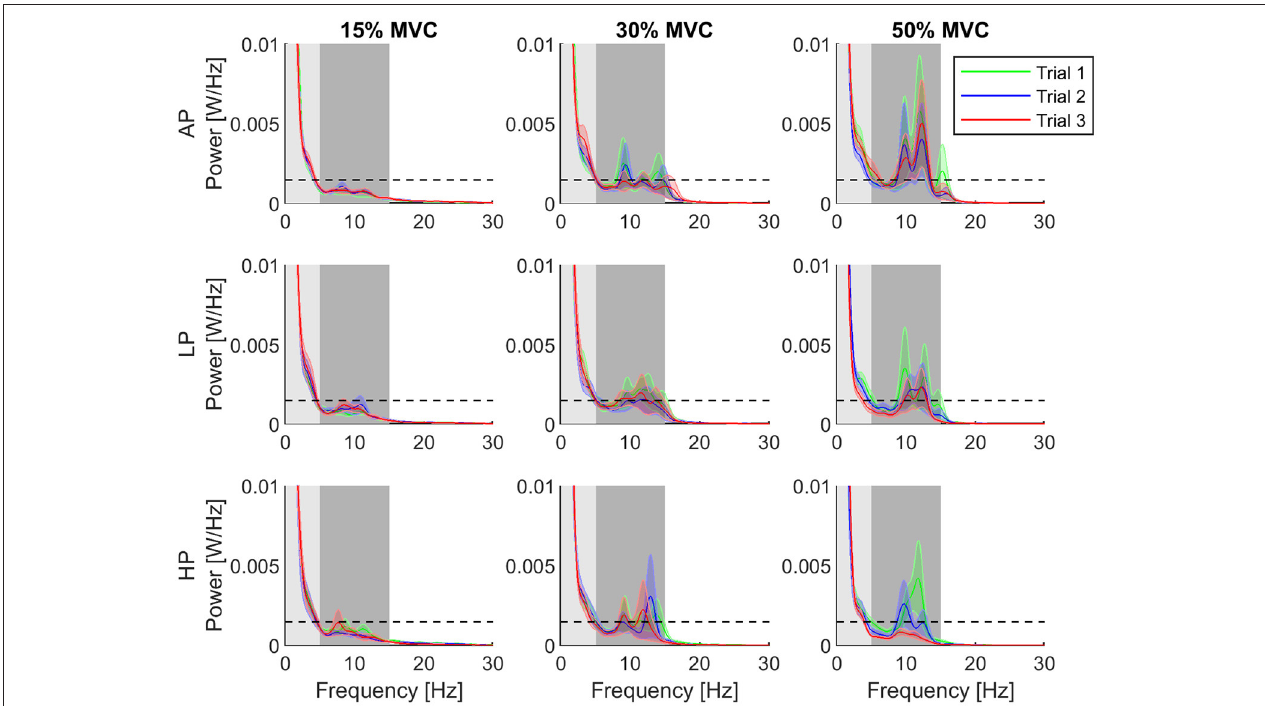
FIGURE 4 | Normalized power spectral density for each condition. The third trial of the high pressure (HP) and torque level 50% is distinguishable decreased compared to the other conditions and trials. Furthermore, the error decreased clearly. Shaded areas showing the individual bandwidths from which the AUC α (dark) and AUC δ (light) were computed. The rows of the grid represent the pressure levels, whereas the columns are assigned to the different torque levels. The data is represented as average (solid line) and standard error (shade) across all the subjects for the three repetitions of the task. Trial 1 is represented in green, trial 2, in blue, and trial 3, in red. The dashed horizontal line depicts the 95% confidence level as a threshold indicating significance.